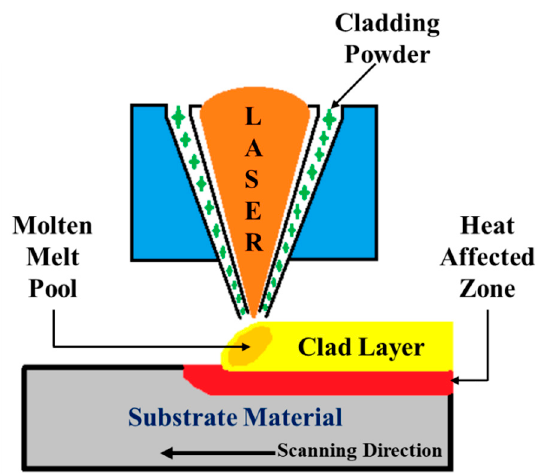
Figure 2. Schematic illustration of the laser cladding process. Table 2. Processing parameters used in the laser cladding process